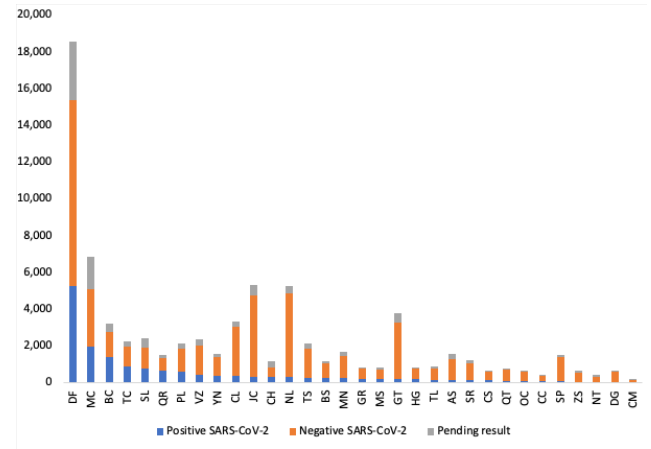
Figure 7. Distribution of cases by state as of April 28, 2020.